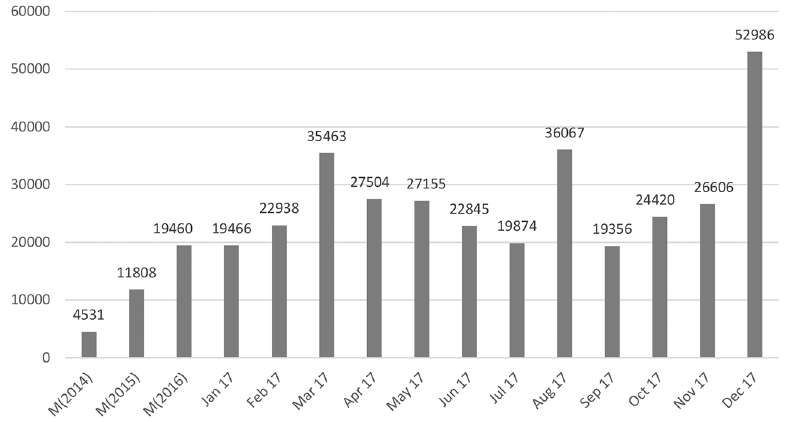
Figure 1. Number of article downloads per month in 2017.